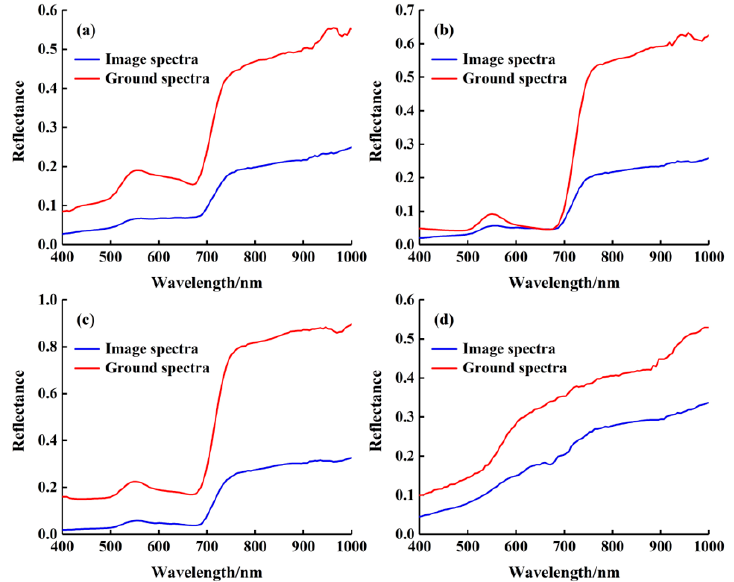
Figure 13. An example of the reflectance of the image and the ground spectra. ( a ) herb, ( b ) shrub, ( c ) tree, ( d ) bare soil. Table 5. The regression results between the image spectra (y) and the ground spectra (x) at 834.83 nm. Correction